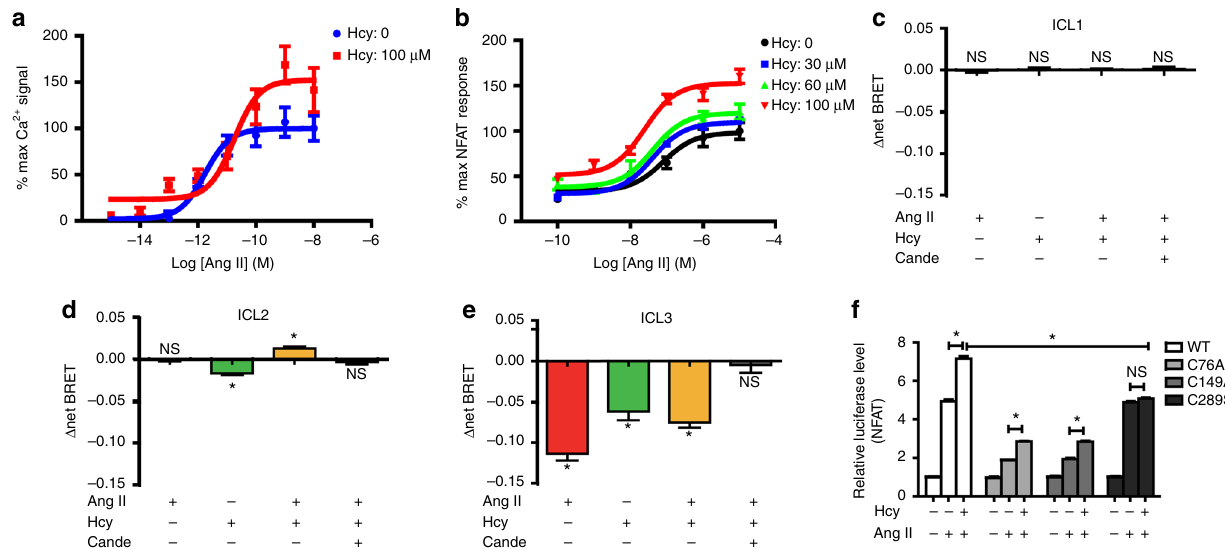
Fig. 6 Hcy and Ang II synergistically activate the AT1 receptor. a Ang II-induced Ca 2+ signaling in the presence and absence of Hcy (100 μ M), detected using Fluo 3-AM and quanti fi ed by the Leica confocal microscope system. The data represent as mean ± SEM, N = 6. b Ang II-induced NFAT signaling in the presence and absence of Hcy (30 – 100 μ M), detected by the dual-luciferase assay system (Promega). The data represent as mean ± SEM, N = 6. c – e Intramolecular Δ net BRET in HEK293A cells (transfected with the three constructs ICL1 – 3) stimulated by Ang II (1 μ M) plus Hcy (100 μ M) with or without candesartan (0.1 μ M) pretreatment. The data represent as mean ± SEM, N = 6, * P < 0.05, Student ’ s t test. f Ang II-induced NFAT activation with or without Hcy in HEK293A cells separately transfected with the C76A-, C149A-, or C289S-mutated AT1 receptor, detected by the dual-luciferase assay system (Promega). The data represent as mean ± SEM, N = 6, * P < 0.05, two-way ANOVA followed by the Bonferroni post hoc EC 50 of Ang II-induced AT1 receptor activation ( − Log[EC 50 (M)) of Ang II vs. Hcy + Ang II: 11.8 ± 0.18 vs. 10.7 ± 0.23, n = 3 independent experiments; % maximum responses of Ang II vs.